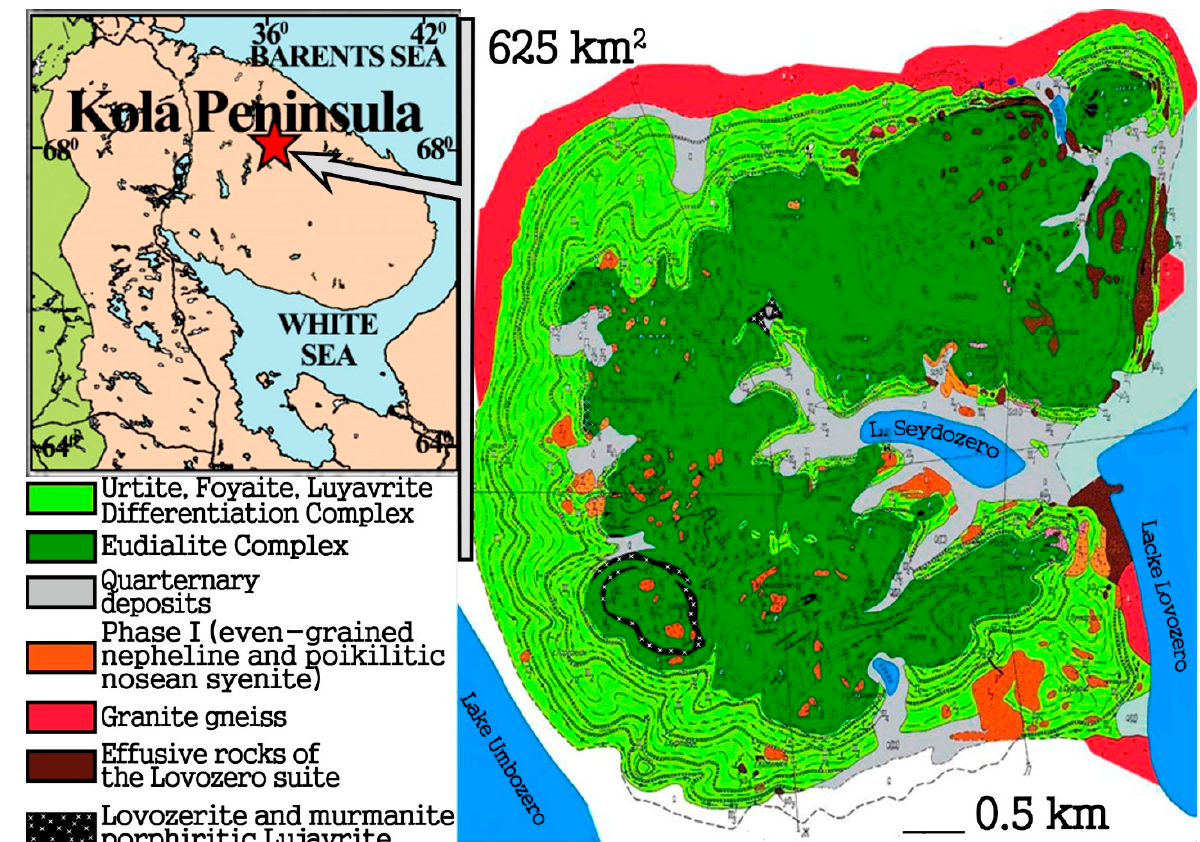
Figure 1. Geological map of the Lovozero complex with inset showing location of Lovozero (star) within the Kola Penin- sula.